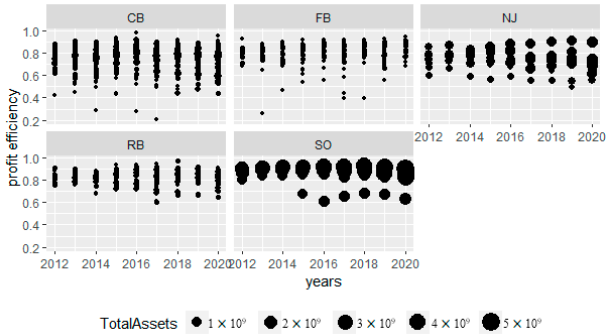
Figure 4. Profit efficiency of different types of banks. Source: author’s preparation. Notes: ordinate axis − the average value of efficiency for the group of banks; abscissa axis − years; categories − groups of banks according to Table 4, where the size of the marker characterizes the size of bank assets, and its representation corresponds to the scale “Total Assets” at the bottom of the figure.